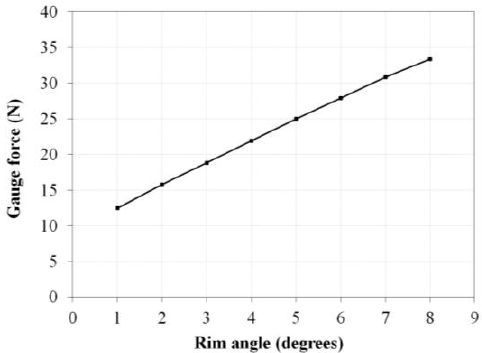
Figure 11. Results of average pull force measured by the push–pull gauge at 1° increments.